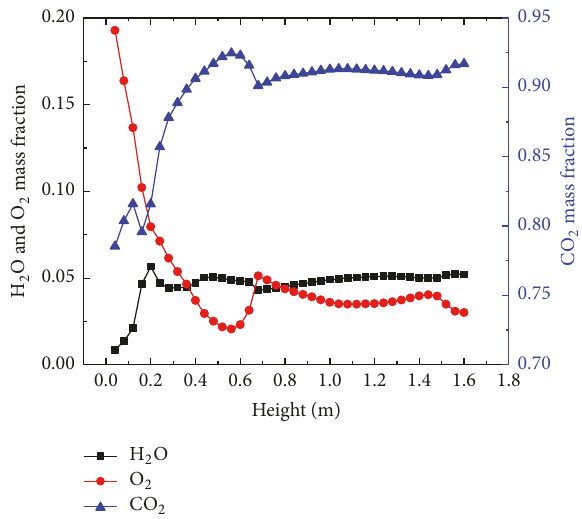
Figure 12: The time- and section-averaged mass fractions of H 2 O, O 2 , and CO 2 along the